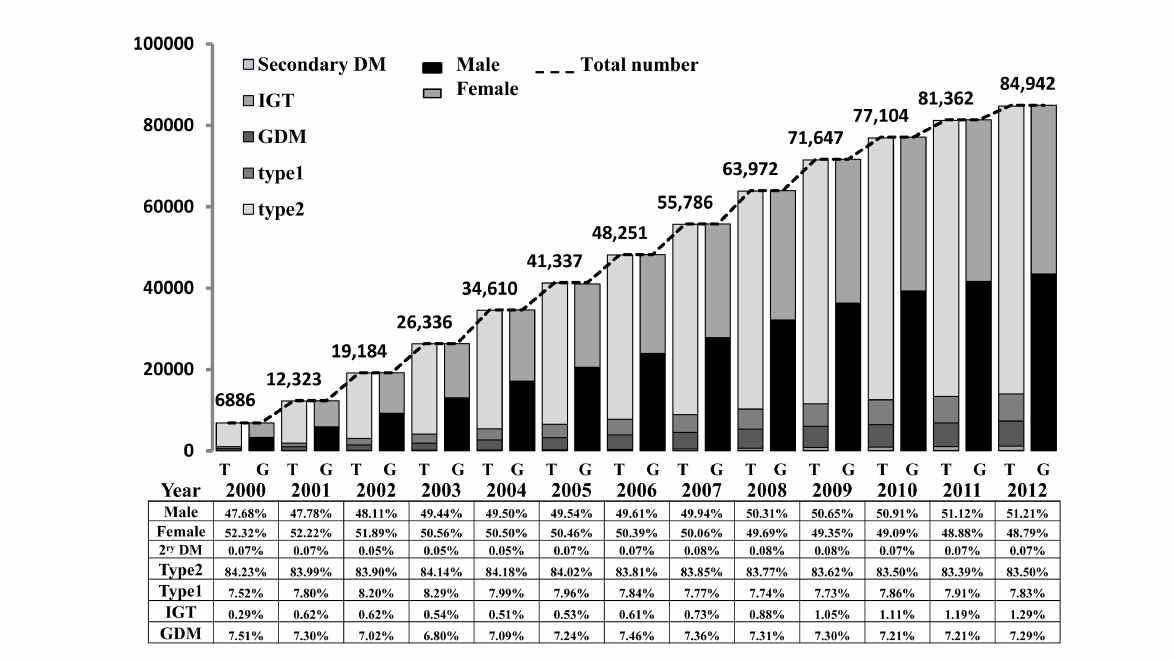
Figure 2. The yearly total number of registered cases of diabetes according to gender (G) and type (T) of diabetes from the start of registry in 2000 to